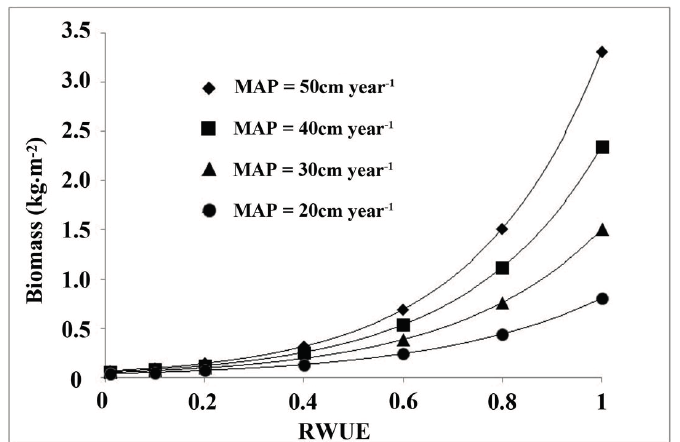
Figure 3. Simulation of the change in biomass predictions by the new Relative Water-Use-Efficiency-Based Model (Equation (6)) for different MAP levels as a result of varying relative water-use efficiency